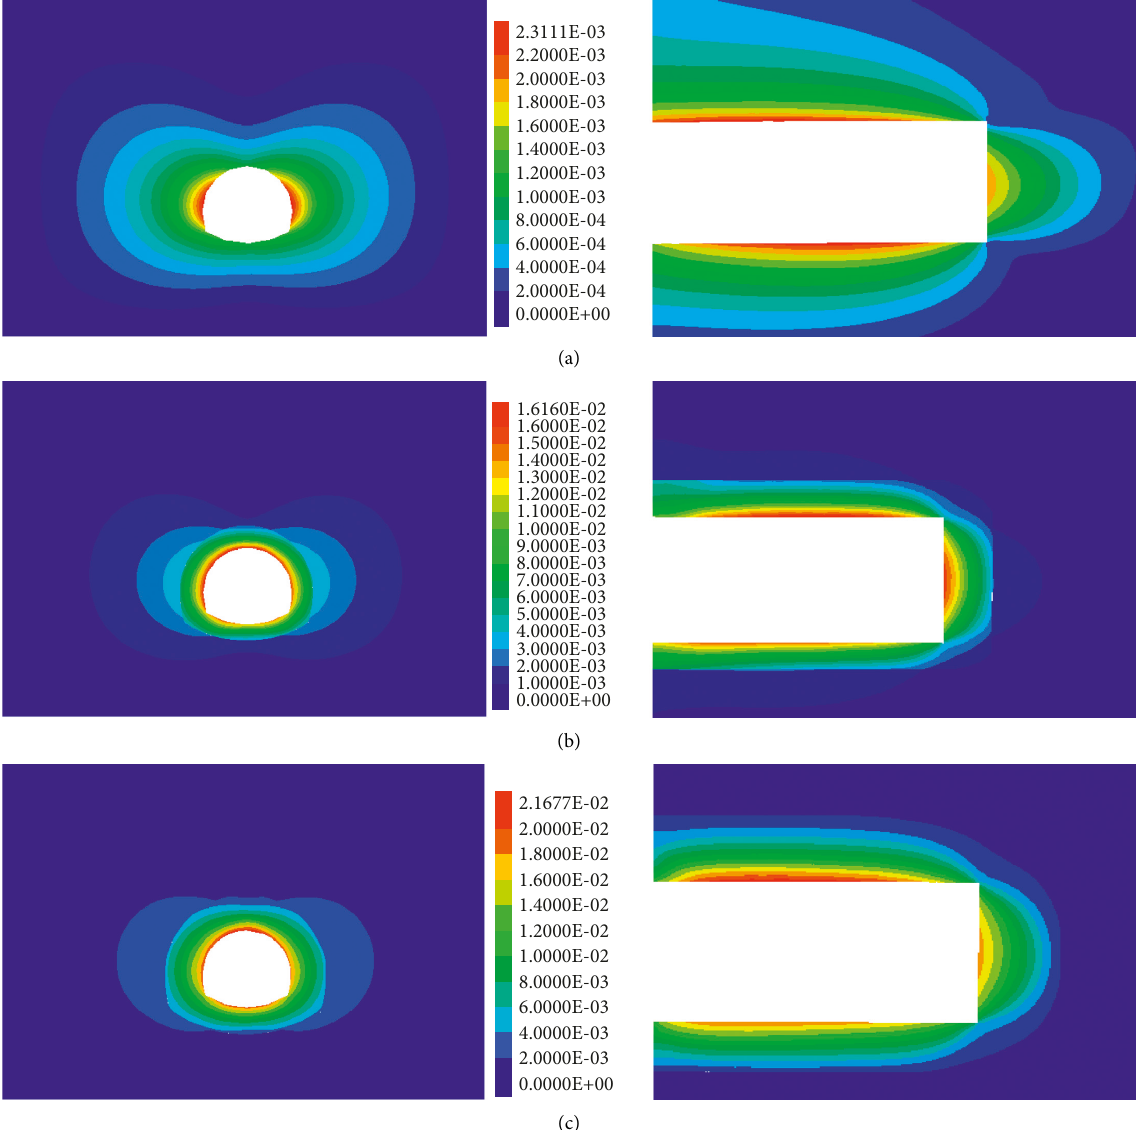
Figure 9: Deformation characteristics of surrounding rock. (a) Tunnel excavation without surrounding rock modification. (b) The modified depth 3m. (c) The modified depth 5m.